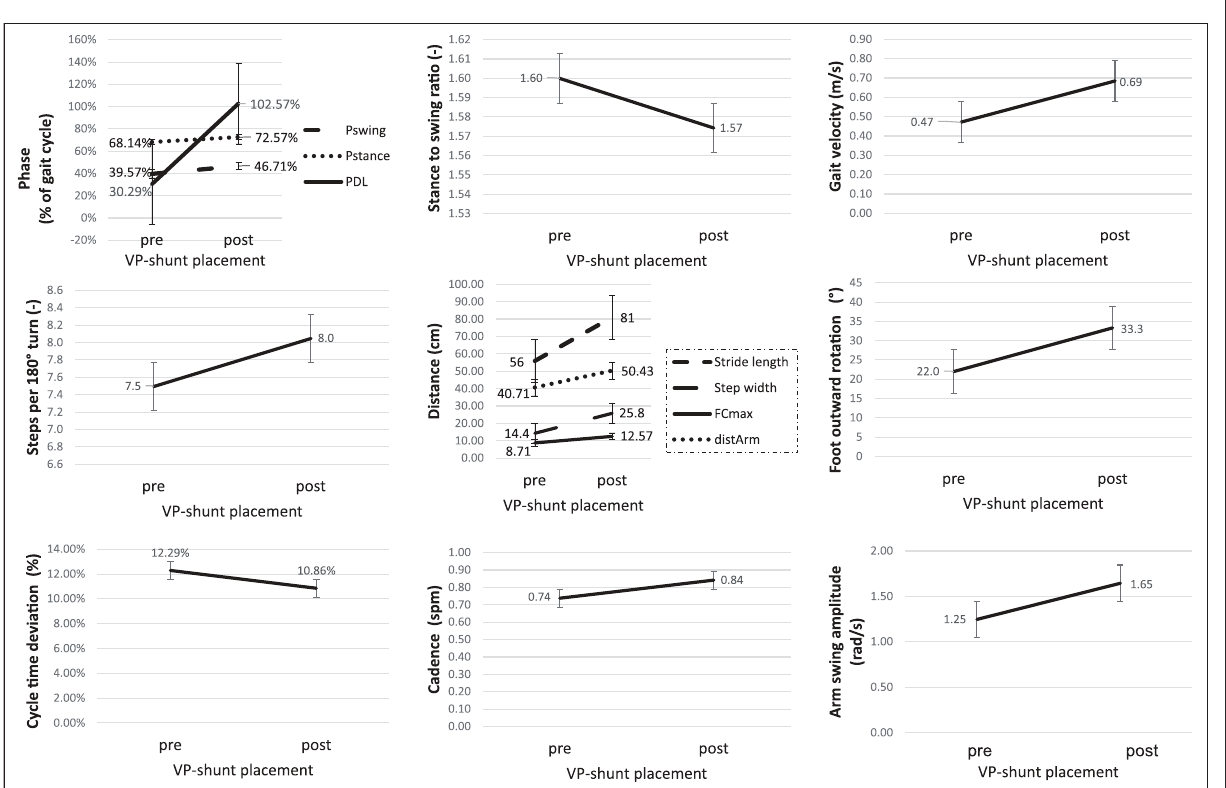
FIGURE4 Graphic illustration of the changes in the gait parameters in the responder’s group (NPH-RR ≥ 5) to VP-shunt implantation. Error bars represent standard errors. Fcmax, maximal foot clearance; distArm, traveled arm; Pswing, swing phase; Pstance, stance phase; PDL, double limb support phase.